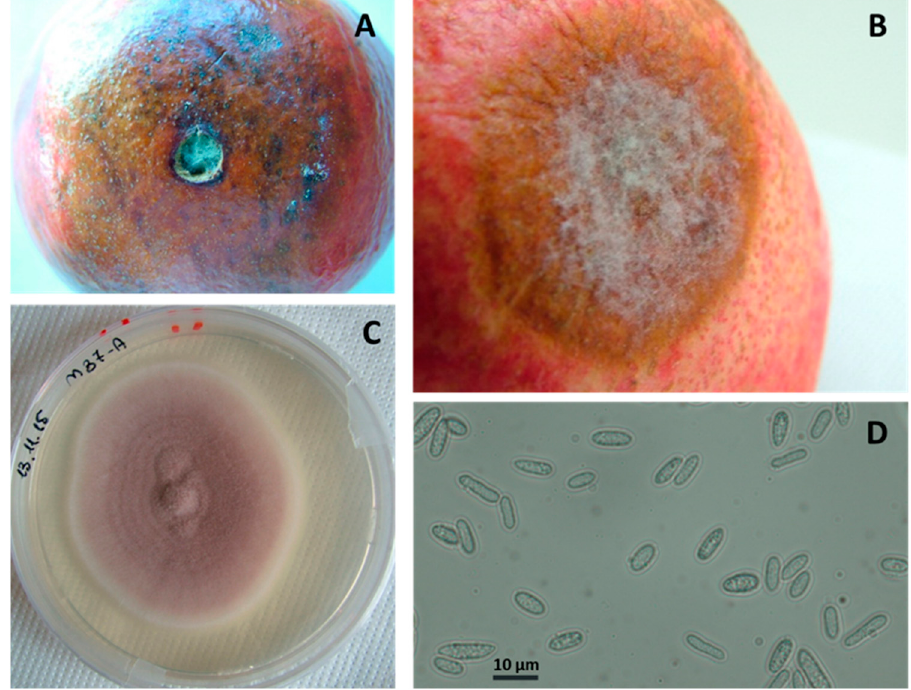
Figure 8. Anthracnose caused by Colletotrichum acutatum s.s. Artificial ( A ) and natural ( B ) infections. ( C ) C. acutatum s.s. colony grown on PDA plate and ( D ) conidia. Cytospora spp. Circular creamy ‐ brownish lesions, centrally darker with soft rind tissue, were observed that corresponded to a subcutaneous area, displaying a yellowish corky appearance (Figure 9A,B). On the PDA plate, monoconidial colonies were at first whitish, then turned olive green and dark brown at maturity (Figure 9C). Globose and dark brown pycnidia (375 ± 125 μ m) covered mycelium after 14 days at 24 ± 1 °C; conidia, which appeared allantoid, aseptate, and hyaline, measured 5 ± 1 × 1.5 ± 0.5 μ m on average. The molecular assay (Table 1) confirmed Cytospora punicae as the representative isolate (Table 2). Figure 9. Artificial infections caused by Cytospora punicae on pomegranate fruit: ( A ) rot symptom, ( B ) close ‐ up of soft rot showing pycnidia. ( C ) Colony on PDA plate. 4. Discussion This investigation was organized in three main sections. In the first, a complete description of the most important fungal pathogens of pomegranate fruit from southern Italy was reported. When comparing the number of symptomatic pomegranates (155) with the number of isolates (346), it appeared that several pathogens coexisted in the same fruit. Concerning the incidence of the fungi, the most abundant pathogen of pomegranate